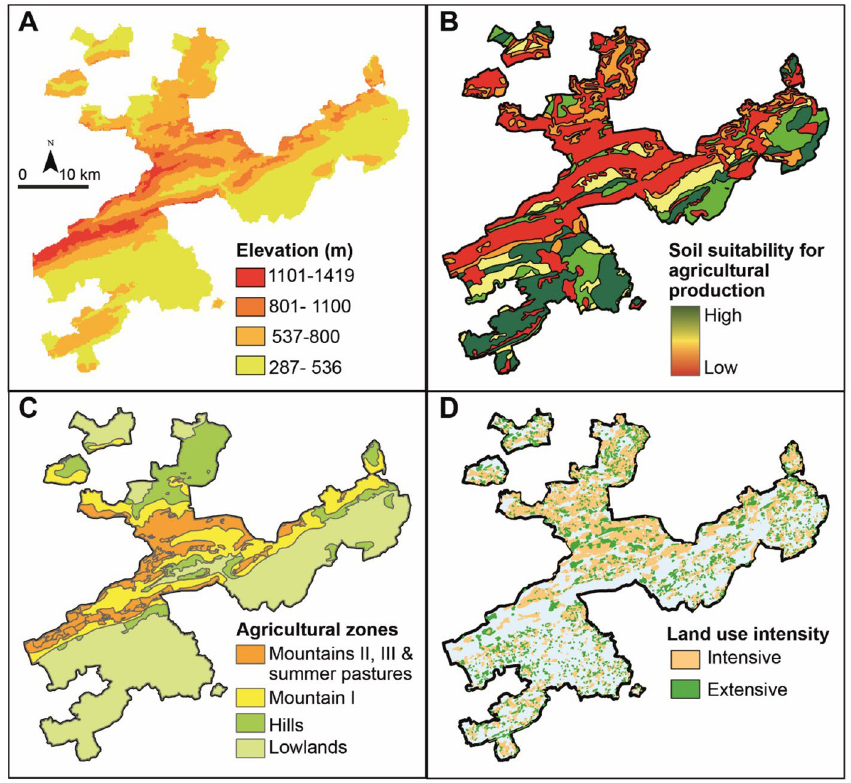
Figure 5. Spatial distribution of the input data for ecosystem service prediction and calculation in the case study region. ( A ) Elevation in m.a.s.l. ( B ) Soil suitability for agricultural production; ( C ) Agricultural production zones. ( D ) Current grassland management in the Canton of Solothurn. Data sources 40,71 (map produced in ArcGIS 10.7.1 www. esri.